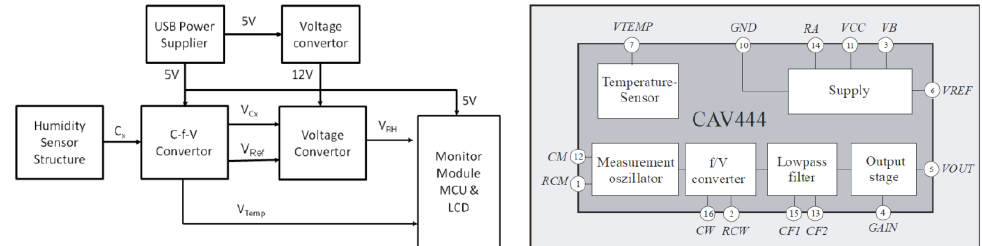
Figure 11. Schematic circuit block of the prototype sensor ( Left ) and block diagram of the CAV444 ( Right ).